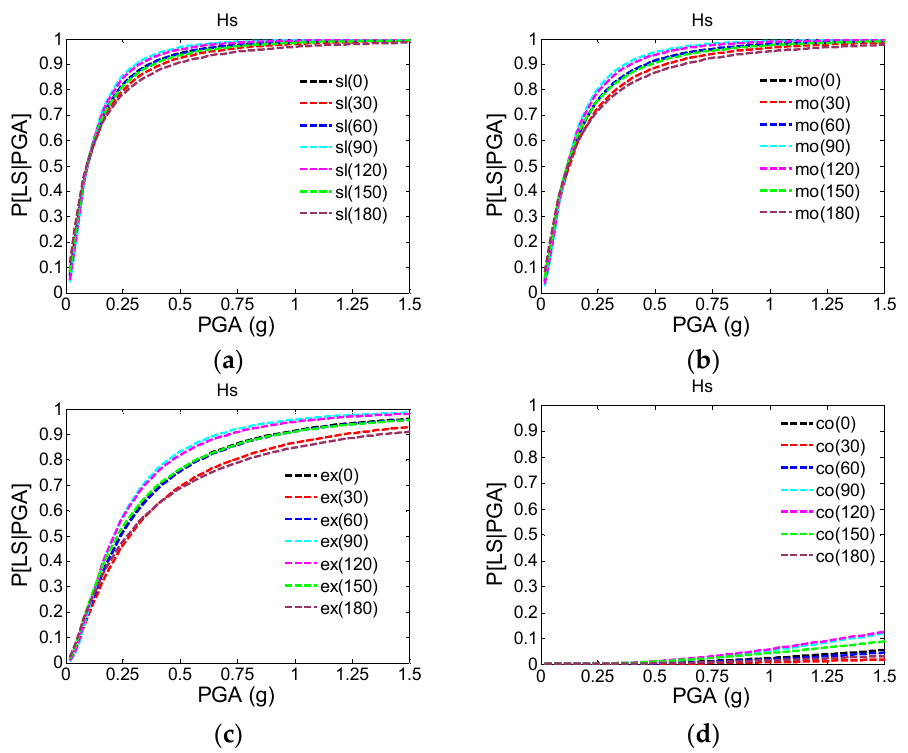
Figure 7. Seismic fragility curves of Hs subjected to different excitation angles in the ( a ) slight; ( b ) moderate; ( c ) extensive; and ( d ) complete limit states.